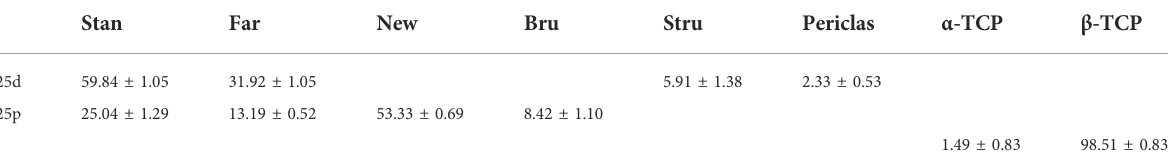
TABLE 5 Chemical composition of Mg225d, Mg225p and TCP in wt%.